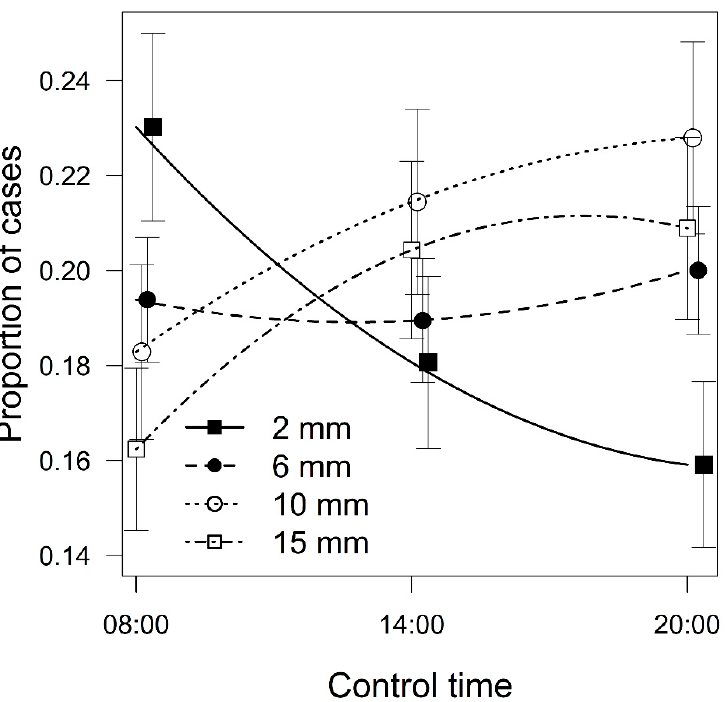
Figure 3. Proportion of cases when beetles chose mosses with preserved spatial structures with varying of the maximal free space among the stems ( flat = 2 mm, reticulate = 6 mm, filiforme = 6 mm, usual = 10 mm, turgid = 15 mm) during the daytime (mean ± standard error, the trends are based on loess). The differences in proportion of cases when beetles chose a moss with given space among stems were tested by generalized estimating equation models with binomial